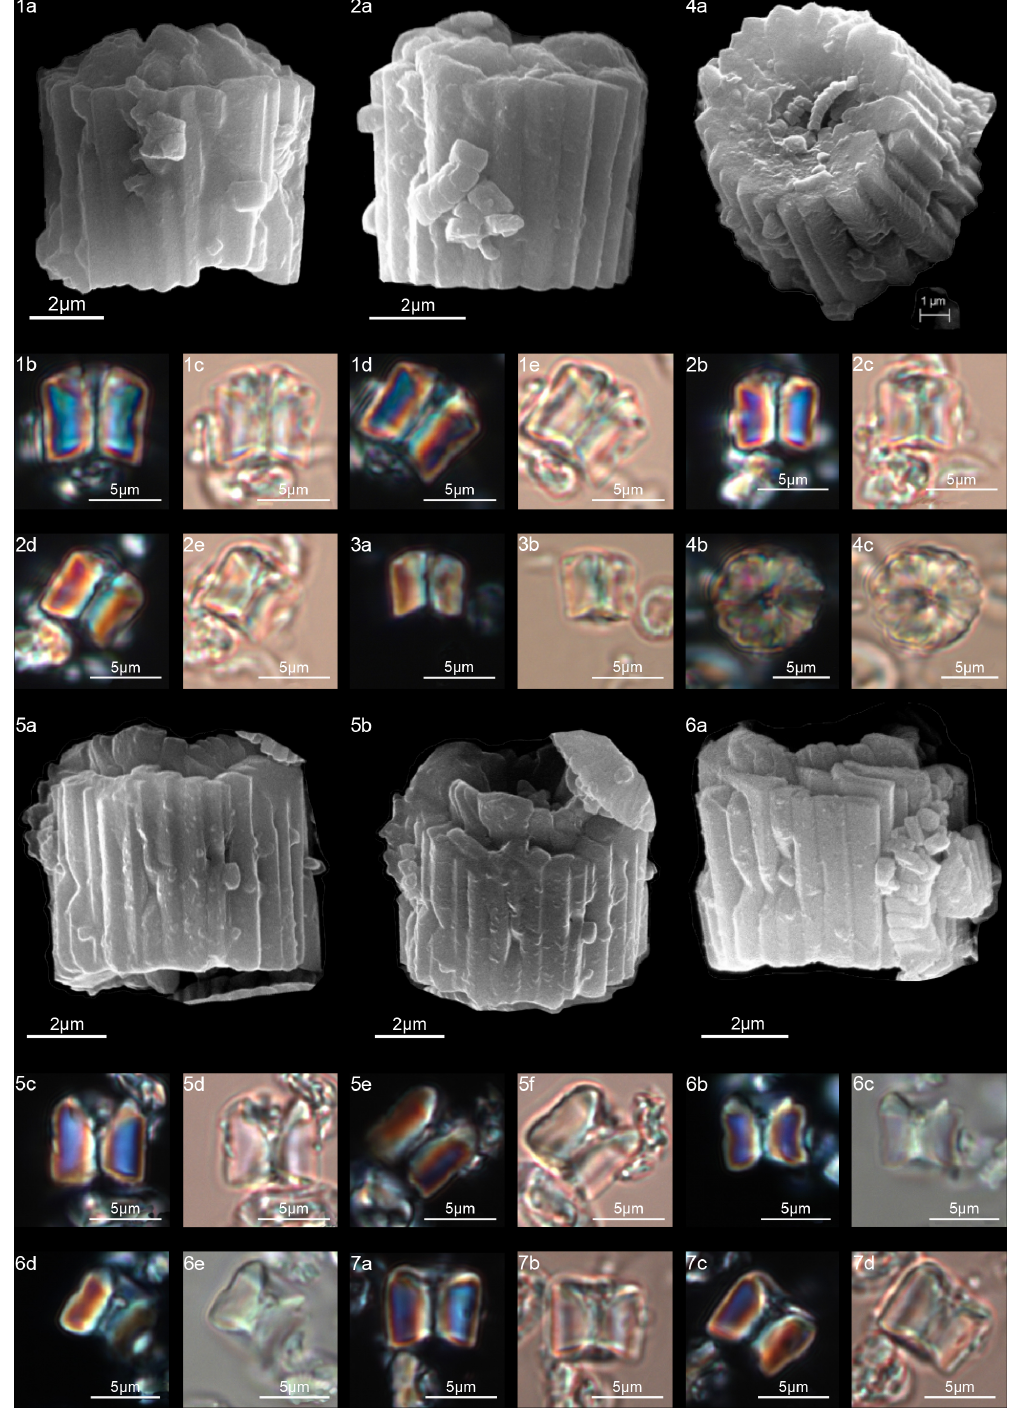
Figure 25. Fasciculithus sp. A. (1) Sample: 1262C 10-3, 74–75. (1a) SEM, (1b, d) XPL, (1c, e) PPL. (2) Sample: 1262C 10-3, 74–75. (2a) SEM, (2b, d) XPL, (2c, e) PPL. (3) Sample: 1262C 10-3, 74–75. (3a) XPL, (3b) PPL. (4) Sample: 1262C 10-3, 74–75. (4a) SEM, prox- imal view; (4b) XPL, (4c) PPL. Fasciculithus realeae . (5) Holotype (IGF 104728). Sample: 1209C-14-1, 56–67. (5a, b) SEM, (5c, e) XPL, (5d, f) PPL. (6) Paratype (IGF 104729). Sample: 1209C-14-1, 56–67. (6a) SEM, (6b, d) XPL, (6c, e) PPL. (7) Sample: 1209C-14-1, 56–67. (7a, c) XPL, (7b, d) PPL. See Table S1 for sample